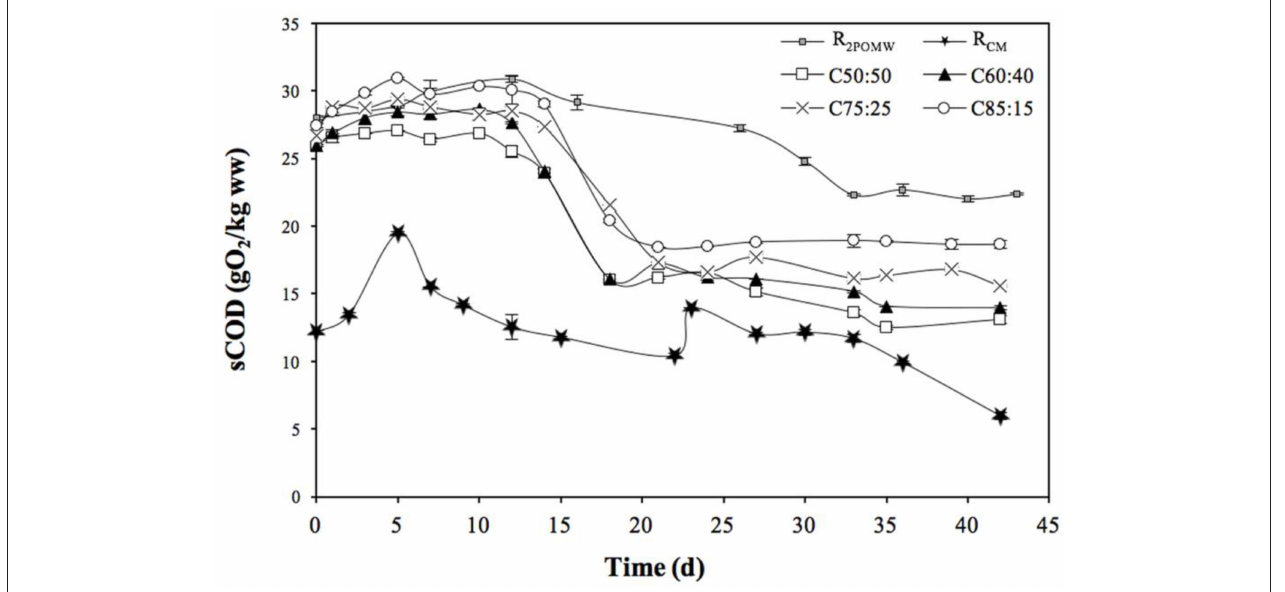
FIGURE 3 | sCOD evolution for 2POMW, CM and co-digestion mixtures in batch experiments.